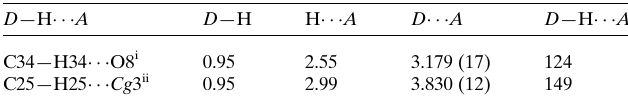
Table 2 Hydrogen-bond geometry (A˚ , (cid:4) ) for 4 . Cg 5 and Cg 6 are the centroids of the C24–C29 and C30–C35 rings.